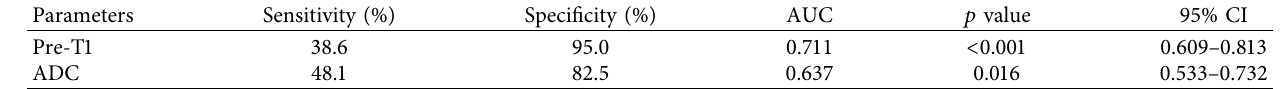
Table 5: Diagnostic value of parameters in the low ( < 30%) or high ( ≥ 30%) Ki-67 proliferation groups.